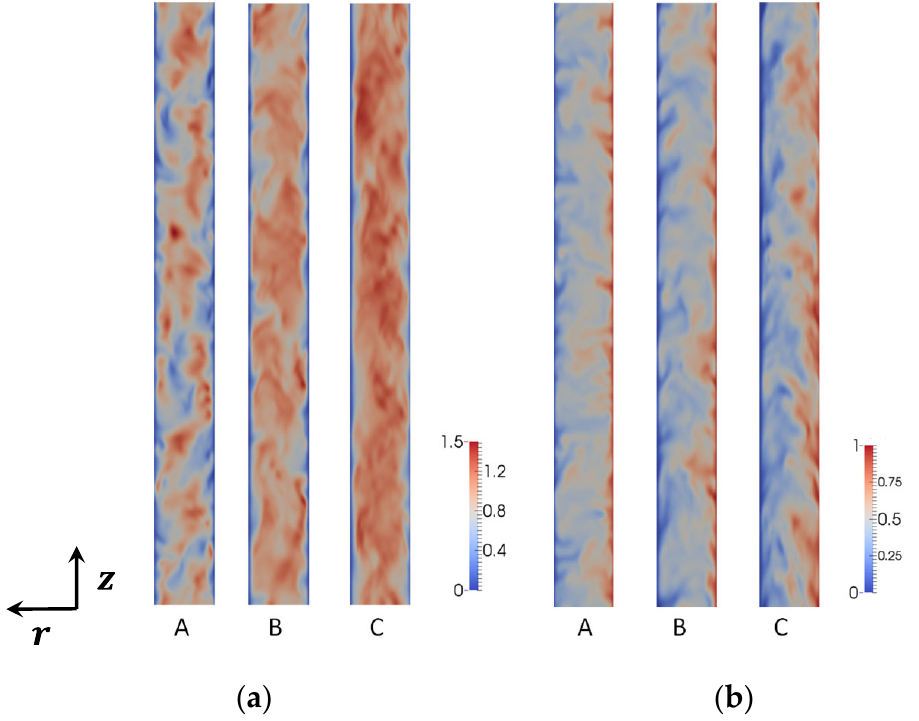
Figure 6. Velocity fields of the streamwise ( a ) and spanwise ( b ) components in a cross ‐ section of the annular geometry (the axis of rotation is on the right side of each figure and the flow moves from bottom to top).